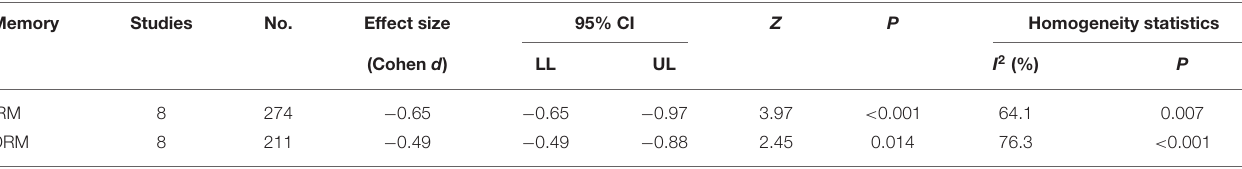
TABLE 3 | Effect size